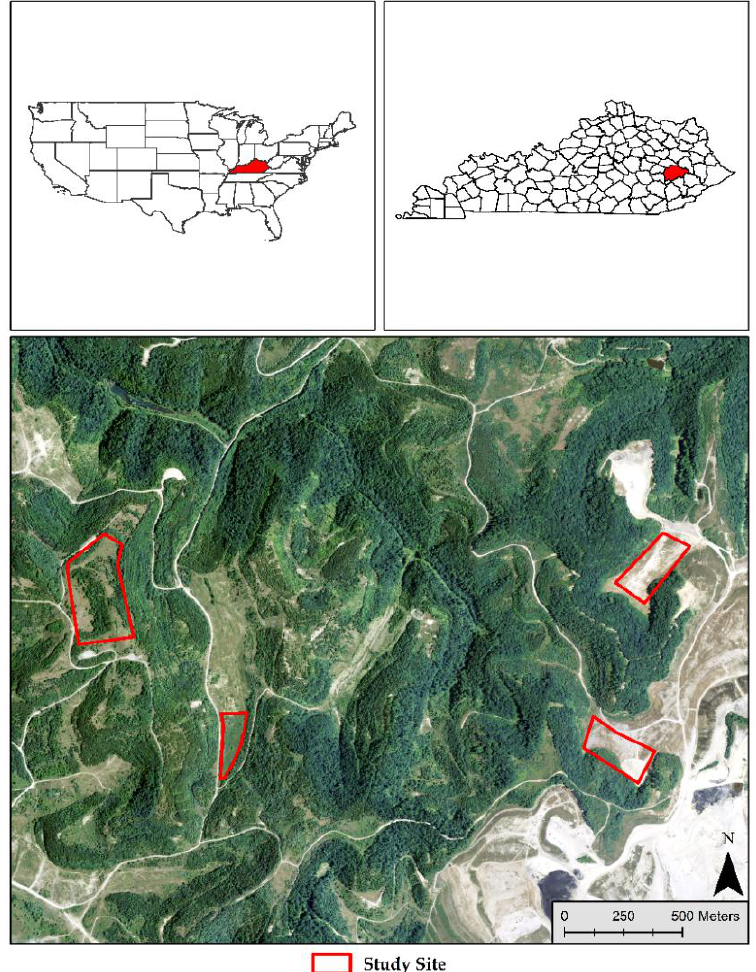
Figure 1. Study location prior to site preparation, Breathitt County, KY, USA. Exotic shrubs and conifers were common in the two western plot locations, and vegetation was relatively absent in the eastern plots.